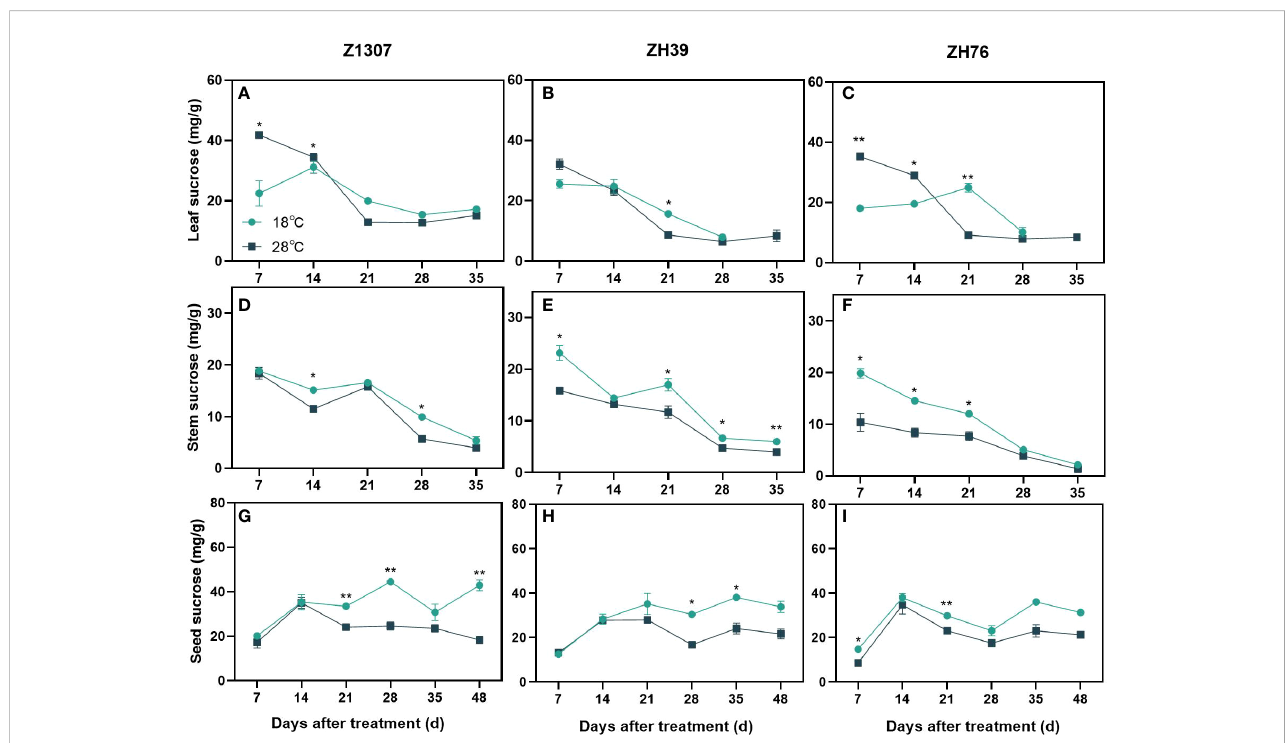
FIGURE 5 Effects of high night temperature on sucrose content in soybean leaf, stem and seed. The light blue/ black blue line indicates the 18 ℃ /28 ℃ treatment. The broken lines respect the dynamic changes of the sucrose content of leaf (A-C) , stem (D-F) and seed (G-I) with the days of different high night temperature treatments for the three varieties of Z1307, ZH39 and ZH76. Values shown are means ± SE from three biological replicates. (*, P < 0.05; **, P <